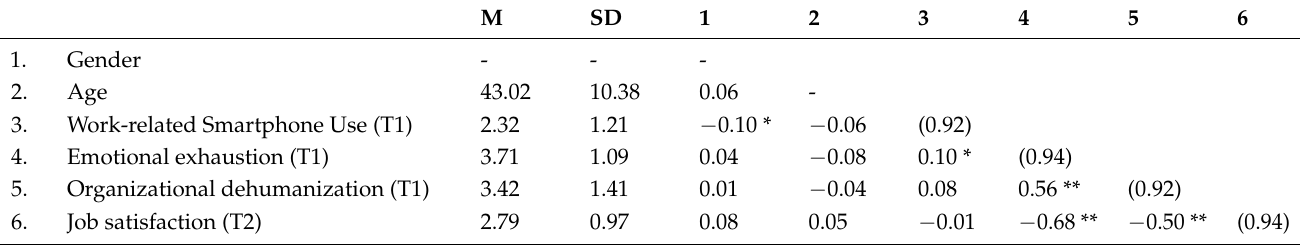
Table 1. Descriptive statistics and